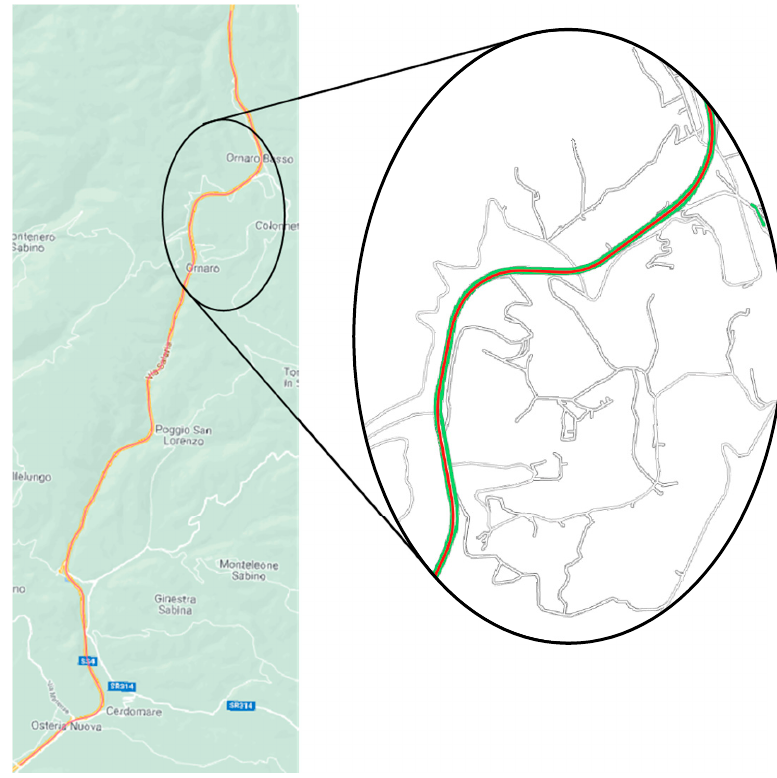
Figure 12. A qualitative comparison between the calculated project axis and the road layout got from a GIS basemap and a zoom of the HWY 4—from the distance 40 km to the distance 55 km.